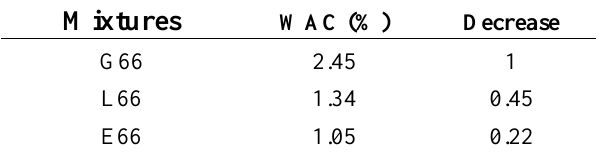
Table 1. Water absorption capacity of tested mortars.